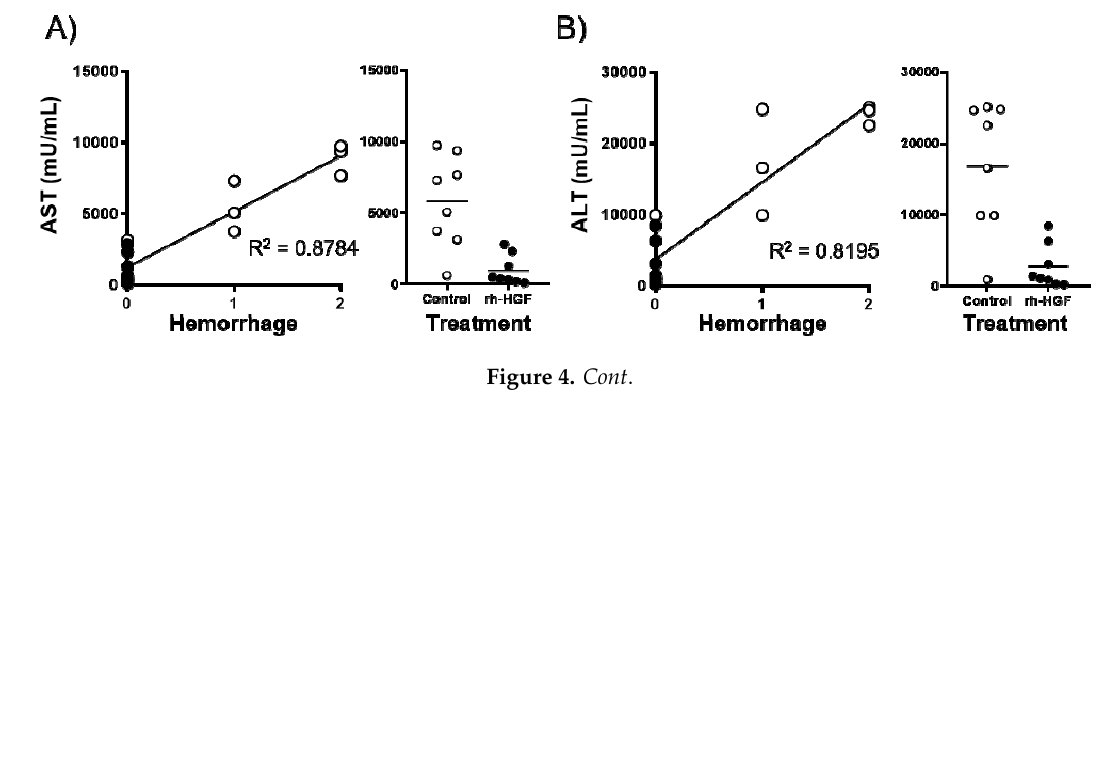
Figure 4. Correlation between the degree of hemorrhage and blood parameters. Correlation analysis between the degree of hemorrhage and ( A ) AST, ( B ) ALT, and ( C ) PT were conducted, and their resulting contribution values (R 2 ) were shown in the left panels. Distributions of each blood parameter were presented according to the treatment (right panels). Average PT (10.6 s) in normal mice was indicated with a dotted line in ( C ). Control (PBS, open circles) or rh-HGF (1.5 mg/kg, closed circles) was administered to the mice. 3. Discussion The prognosis of ALF has been improved by etiology-based treatments and advanced artificial liver support, but there is no doubt that further improvements are required. Especially for patients with hepatic coma, liver transplantation remains the only curative measure. Because transplantation is not always available, a new treatment that can stop the progression of liver damage is needed. HGF is thought to be a potent treatment because of its strong anti-apoptotic effect and stimulation of tissue repair activities [4,5,10]. Although a clinical trial of rh-HGF was previously conducted (Clinicaltrial.gov identifier: NCT03014895), its therapeutic efficacy in ALF remains unknown. Additionally, histological assessments of the pharmacological effects of rh-HGF are difficult in clinical settings. Therefore, in the present study, we first confirmed the anti-apoptotic effect of rh- HGF using cultured human hepatocytes; thereafter, we investigated the histological characteristics of the liver after rh-HGF treatment in an ALF mouse model. We included mouse PT measurements because PT is one of the most important parameters for assessing the functional liver mass in ALF. In the present study, anti-apoptotic effects of rh-HGF were clearly observed in a human hepatocyte injury model (Figure 1) and mouse ALF model (Figure 2). In both models, rh-HGF suppressed cell death machinery (Figures 1A and 2D), which was associated with the prevention of the release of cell components to outside of cells (Figures 1B and 2A,B,E). The in vivo effects of rh- HGF were well depicted by the strong suppression of hepatocellular damage (Figure 3A,B) and an associated decrease in intracellular caspase activation (Figure 3D). Surprisingly, the occurrence of intrahepatic hemorrhages was dramatically reduced to non-detectable levels with rh-HGF (Figure 3A,C); however, there were scattered areas of damaged hepatocytes with increased AST and ALT levels (Figures 2A,B and 3A). Diffuse and massive intrahepatic hemorrhage is known to be one of